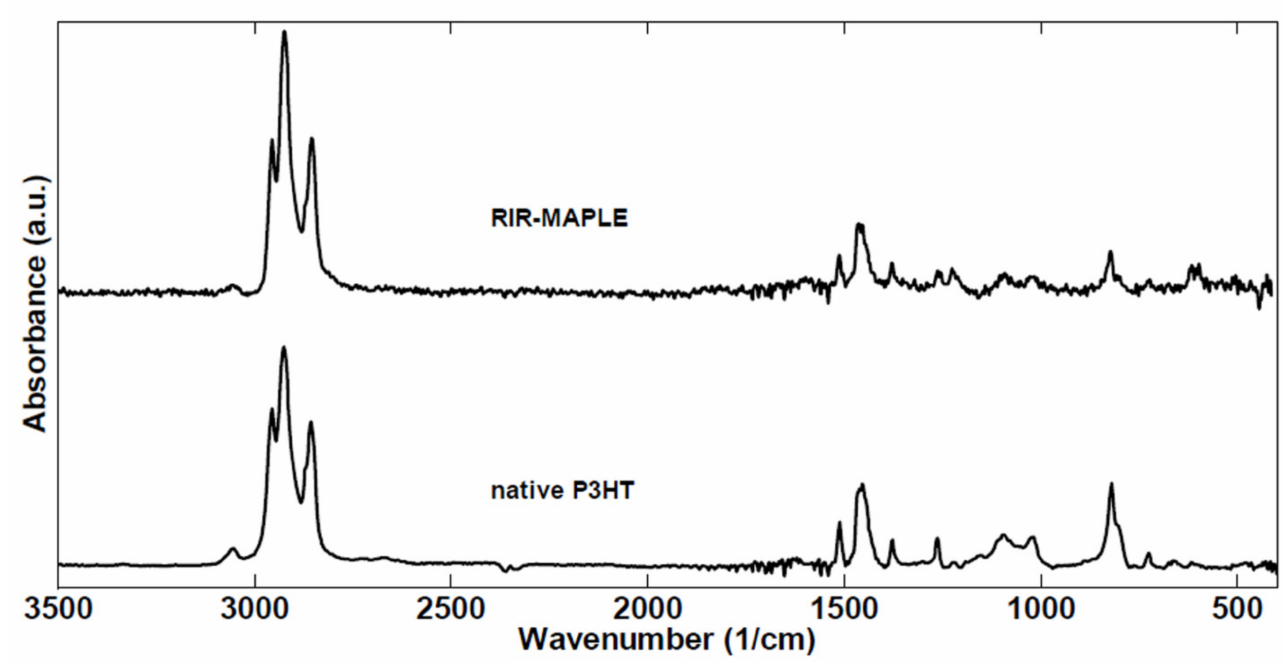
Figure 3. FTIR spectra of P3HT native polymer and P3HT films deposited using RIR-MAPLE. Reprinted from